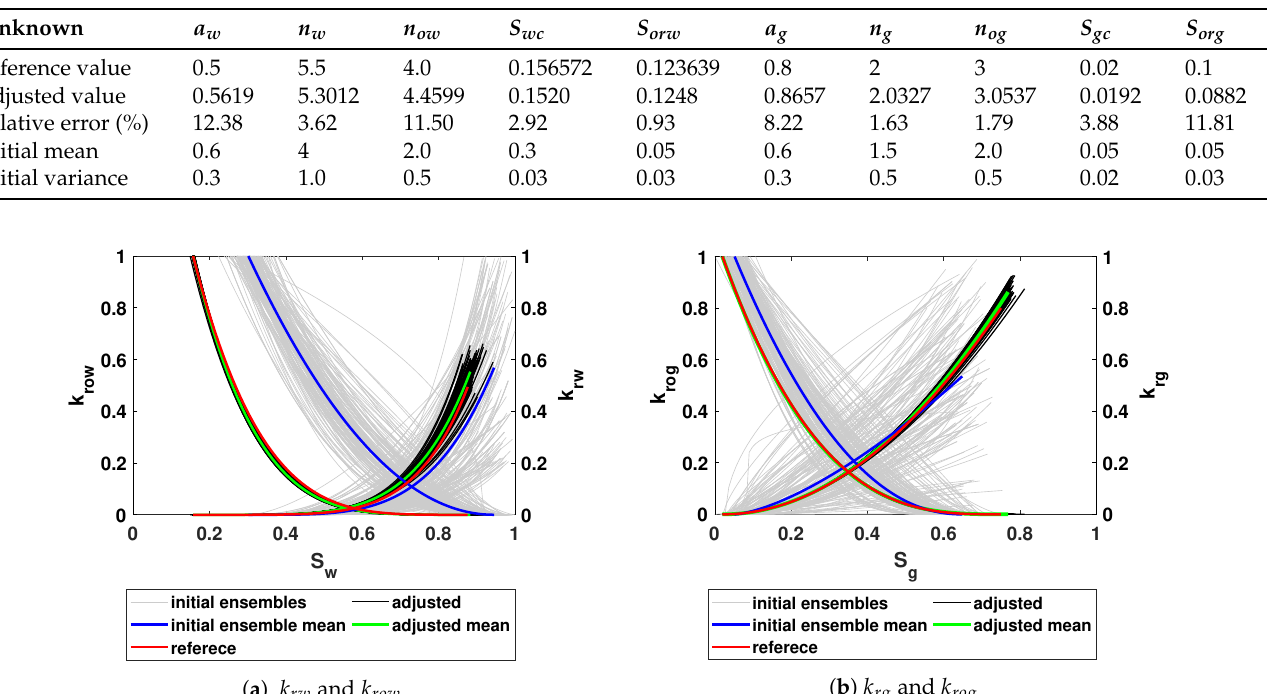
Figure 8. Initial ensembles, initial ensemble means, adjusted values and reference values with unknown endpoints: ( a ) k rw and k row ; ( b ) k rg and k rog